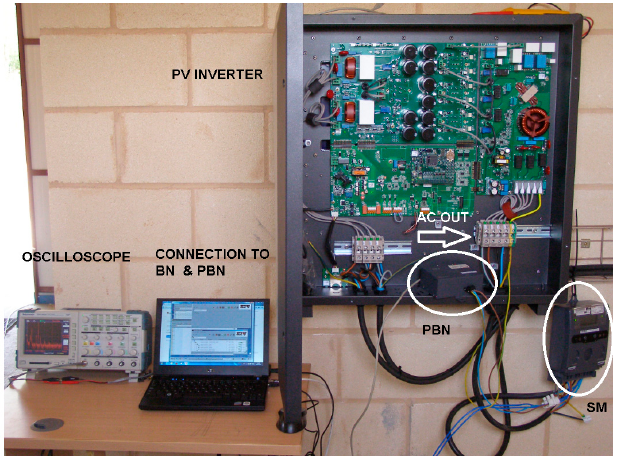
Figure 3. Experimental setup used in the measurements.